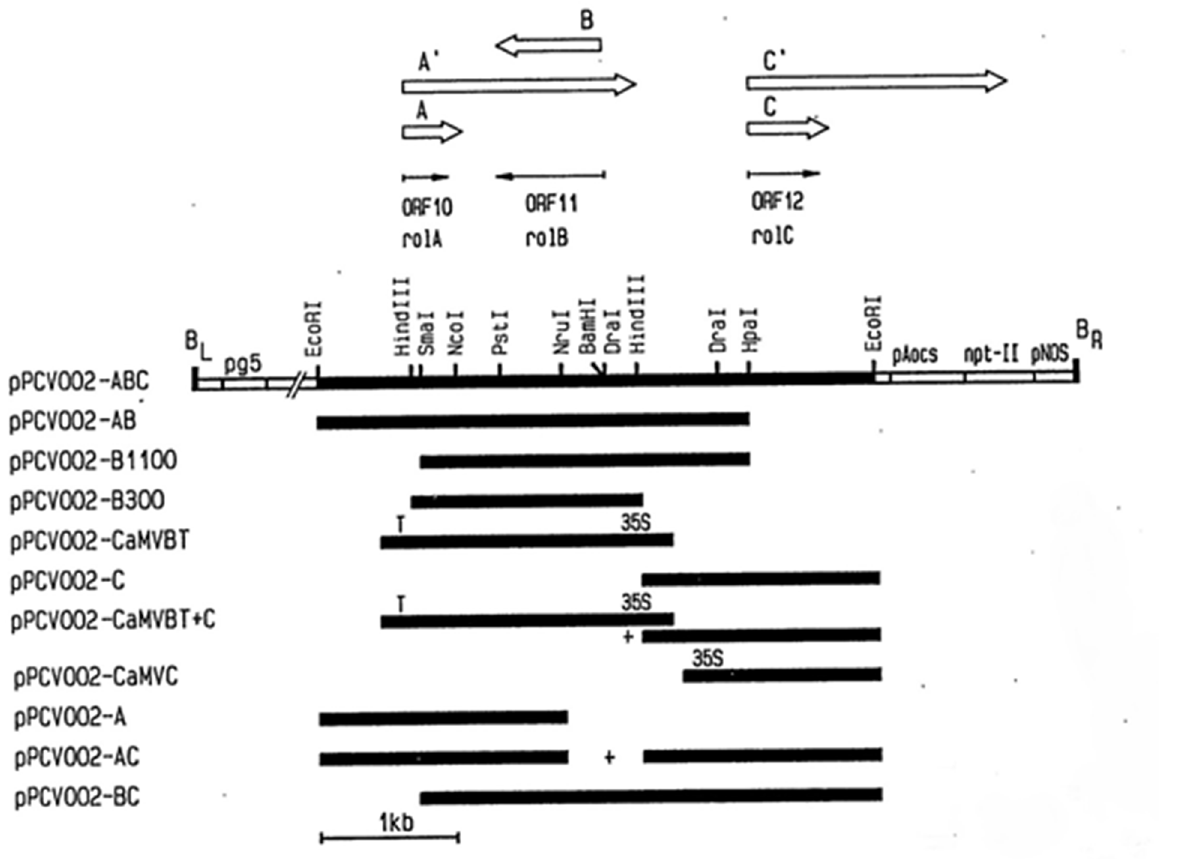
Fig 3. Detail of vectors used for transformation of A . carvifolia . Vectors (pPCV002-CaMVBT and pPCV002-CaMVC) used in the transformation of Artemisia carvifolia . Fig taken from literature [26].